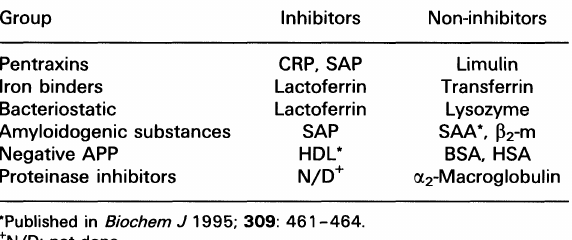
Table 2. Acute phase proteins as inhibitors of sPLA 2